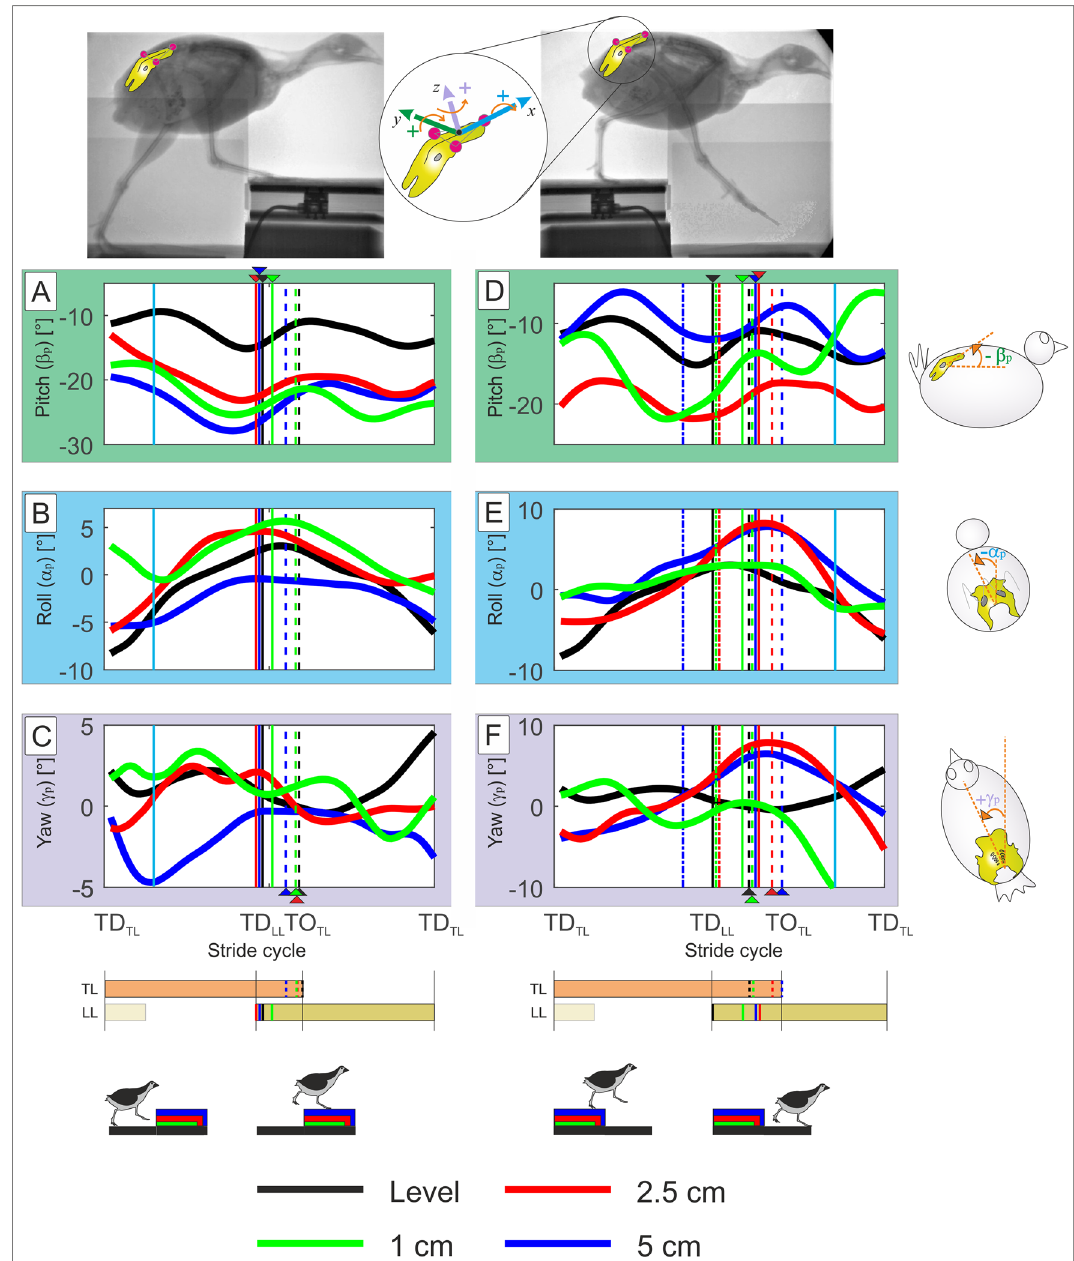
Figure 5. Pelvic three-dimensional rotations during level (black) and step locomotion in the quail. Curves display mean values. Left: step-up locomotion, right: step-down locomotion. For better understanding, we transformed the data to ensure that the trailing limb is always the left leg and the leading leg the right one (see methods). ( A , D ) pelvic pitch (β p ), negative values indicate retroversion (trunk is more vertical oriented). ( B , E ) pelvic roll (α p ), positive values indicate that the trunk tilts towards the right. ( C , F ) Pelvic yaw (γ p ), positive values indicate that the body is directed towards the left. Black, blue, red, green dashed lines indicate toe-off of the contralateral leg (TO), while solid lines touch down (TD). Dot dashed lines indicate when the leg crossed level line during drops. Cyan solid lines indicate 15% and 85% of the stride. TL trailing limb, LL leading limb. Due to the constrained field of view in the X-ray fluoroscope, hip data was often missing at the beginning and at the end of the stride cycles and average values might be less